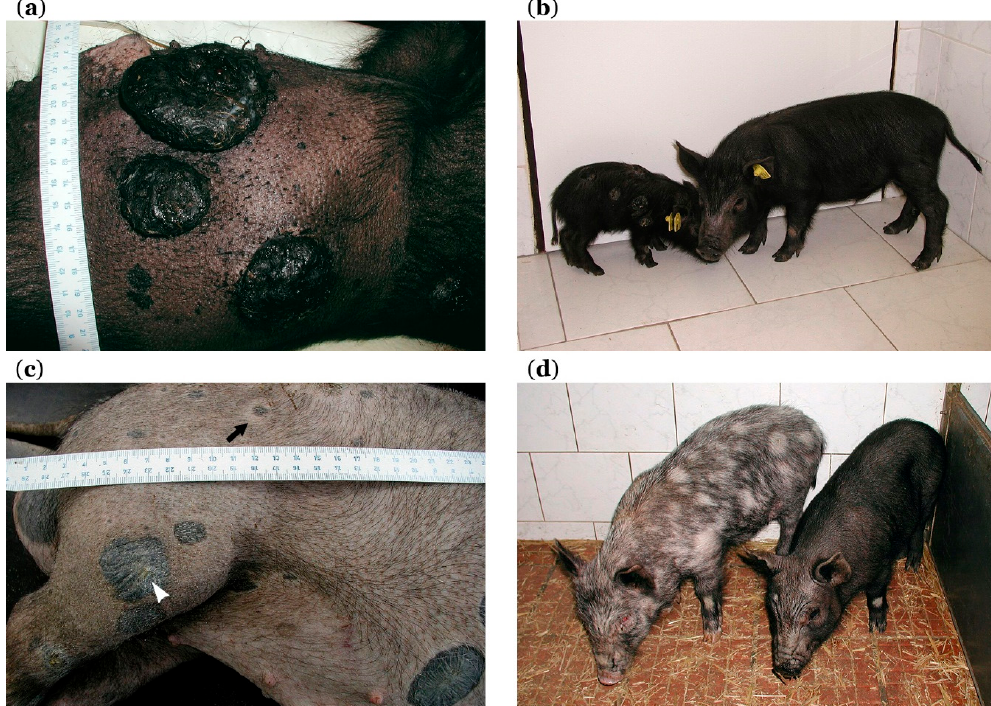
Figure 3. Progression and spontaneous regression in MeLiM model: ( a ) three growing cutaneous nodular melanomas (with local necrosis) are well visible after shaving off the bristles (age 11 weeks); ( b ) comparison of two MeLiM siblings, one with melanoma progression causing heavy cachexia and body size reduction (left side) and one with spontaneous regression and normal body size (right side) (age 10 weeks); ( c ) flattening and graying of originally nodular melanoma (arrowhead) and halo around one smaller melanoma (arrow), together with partial depigmentation of skin and bristles observed in MeLiM pig with ongoing spontaneous regression of melanoma (age four months); ( d ) partial bristle and skin depigmentation versus preserved black pigmentation in two MeLiM siblings with spontaneous regression of melanoma (age 5.5 months); scales in cm.